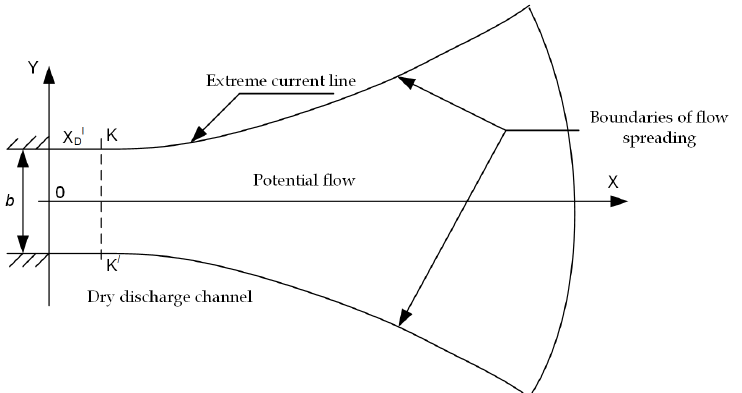
Figure 2. Schematic of a potential supercritical flow behind an unpressurised pipe into a wide, plain horizontal